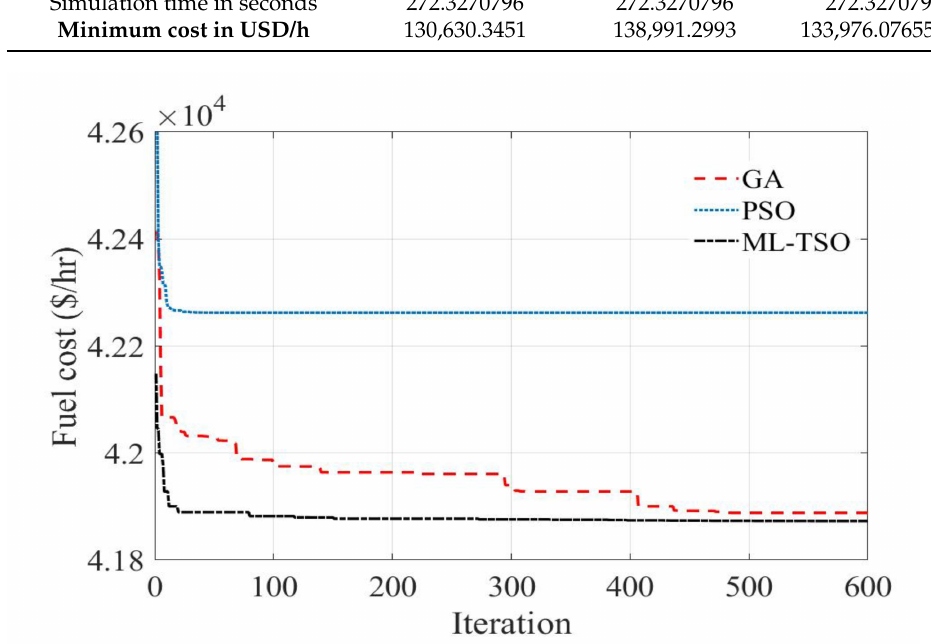
Figure 6. Cost function vs. iterations in the 57-bus